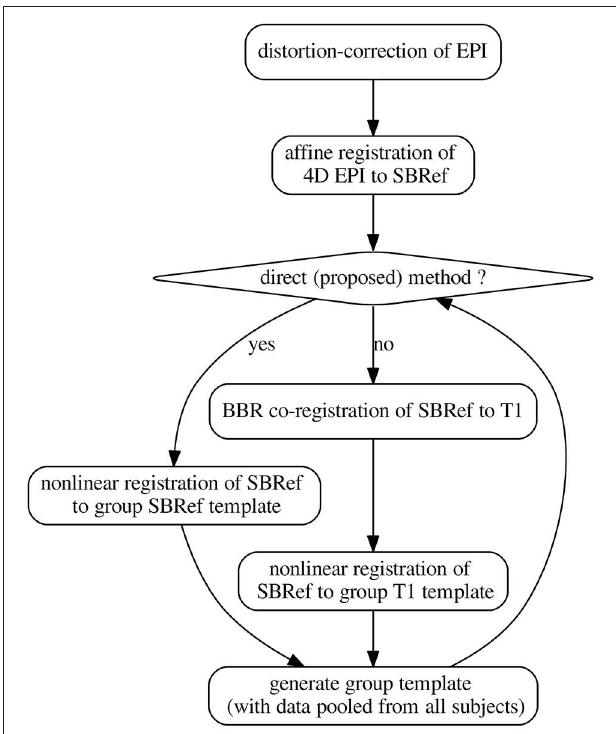
FIGURE 2 | The pipelines. The template-generation step is done using ANTs ( Avants et al., 2008, 2011). It pools registered data from all subjects. N.B.: SBRef, single-band reference image; i.e., high-resolution 3D volume EPI. As in Glasser et al. (2013), all the transformations are postponed and the original 4D EPI is resampled at the end by applying the composition of these transformations in a single